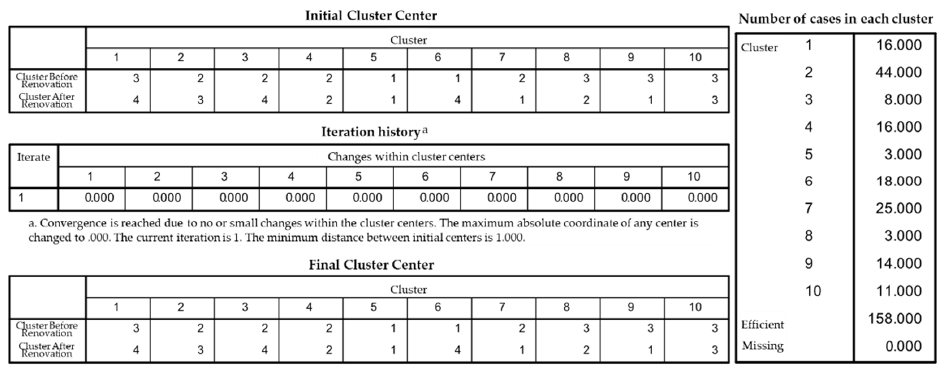
Figure A4. K ‐ means clustering analysis of other buildings after renovation.